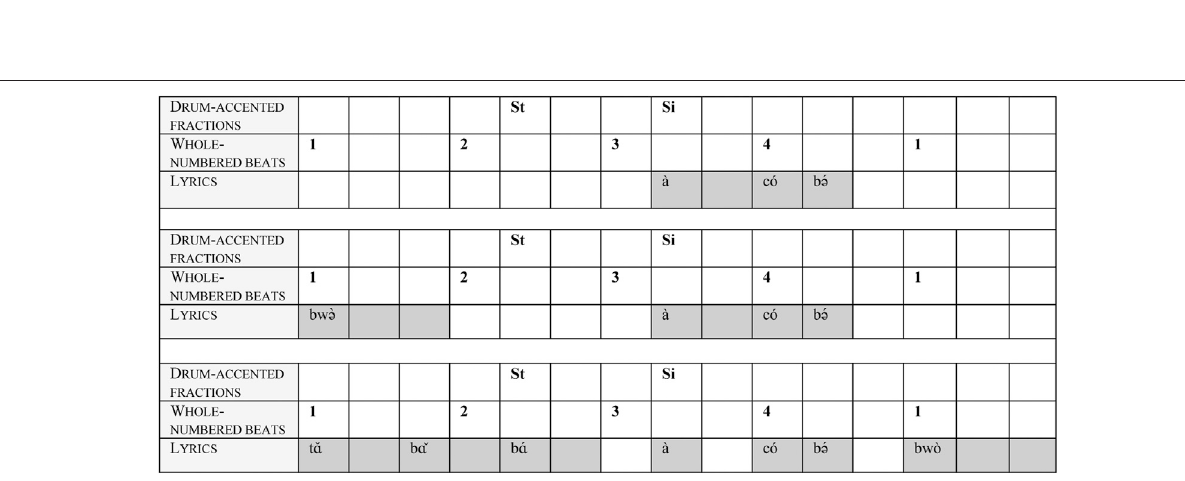
FIGURE 6 | Dancers ’ synchronized forward steps occur on every other attack of the idiophone and shaker.